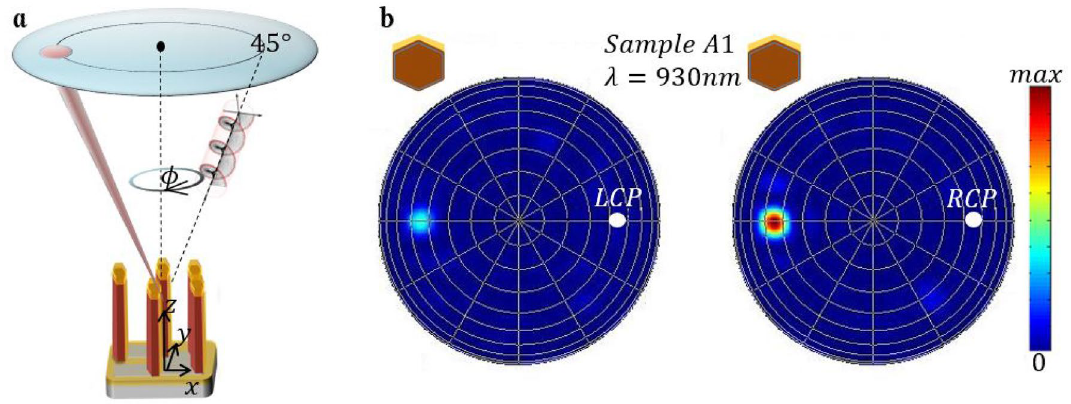
Figure 5. ( a ) Sketch of the simulation set-up. ( b ) Far-field for LCP and RCP excitations of Sample A1, at and 930 nm. White circles denote the position of the incoming